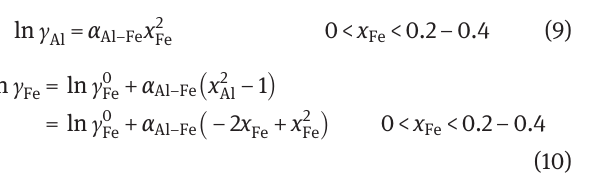
Figure 2: Comparison among calculated activity coefficient ln γ Duhem integral method or Darken ’ s quadratic formalism for three categories of Fe – Al binary melts (a, b, c) with different ranges of mole fraction x Al of Al at various temperatures greater than 1373 K (1100°C),